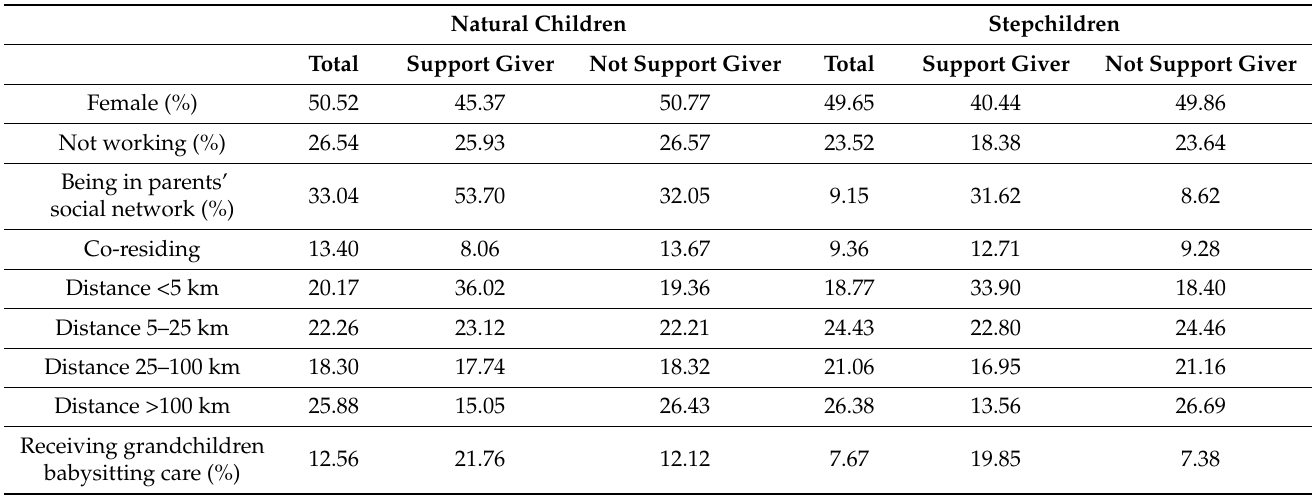
Table 1. Descriptive statistics of children in stepfamilies, by giving non-financial support.